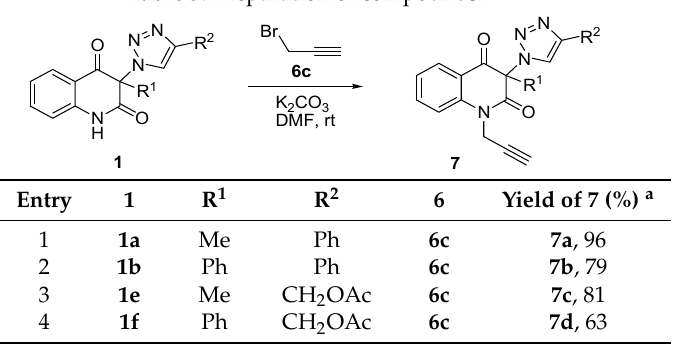
Table 3. Preparation of compounds 7 .